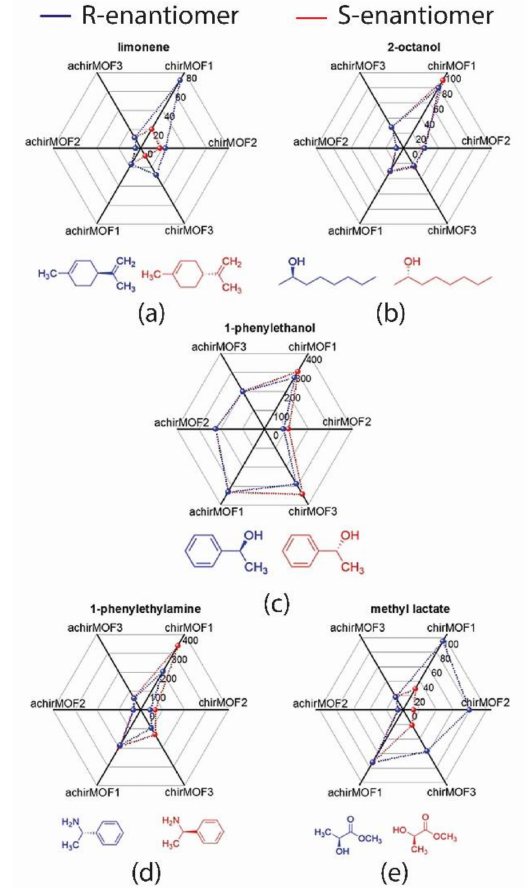
Figure 3. Radar plots of the sensor response towards ( a ) R / S limonene, ( b ) R/S 2-octanol, ( c ) R/S 1-phenylethanol, ( d ) R/S 1-phenylethylamine, and ( e ) methyl R/S lactate. The concentration is 50 ppm. Adapted from Ref. [27], Copyright 2021 Wiley